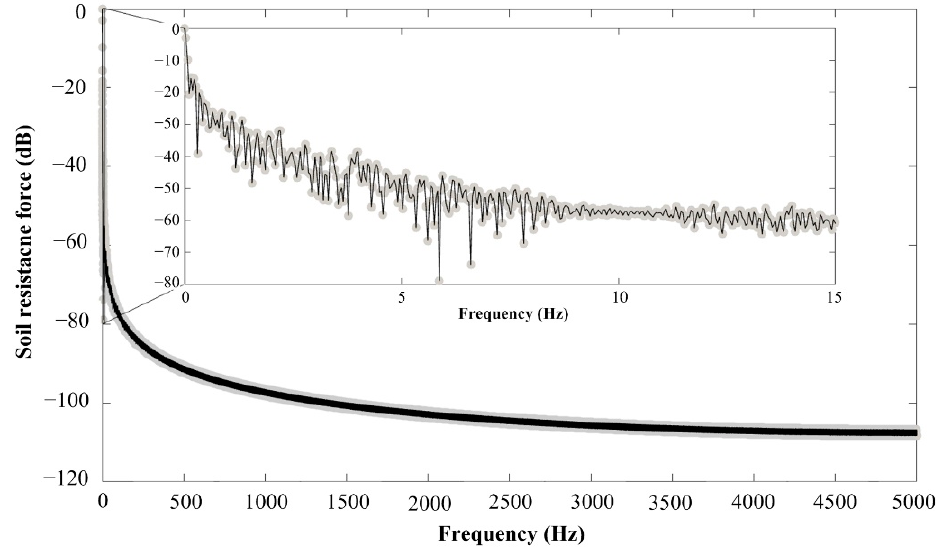
Figure 8. Single-sided amplitude spectrum of soil resistance force.